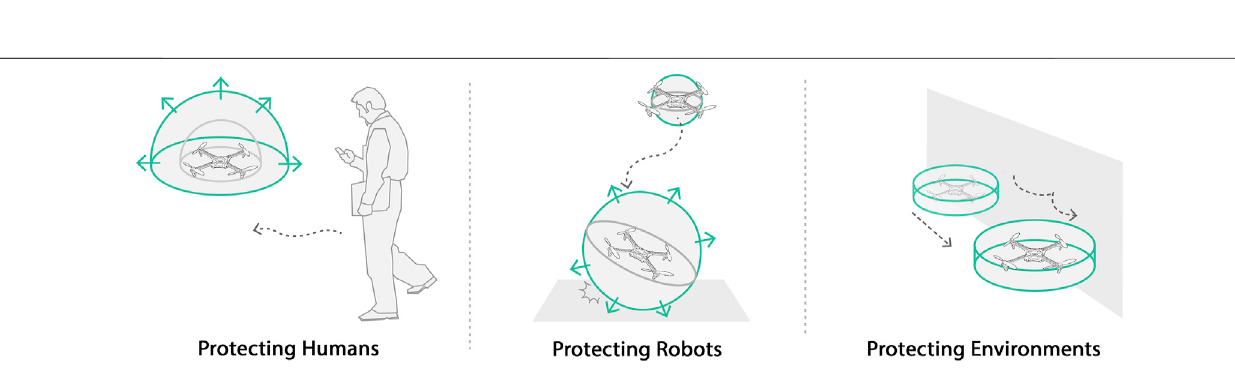
FIGURE 6 | Robots with expandable structures can improve the safety of collocated humans, the robot itself, and the environment.